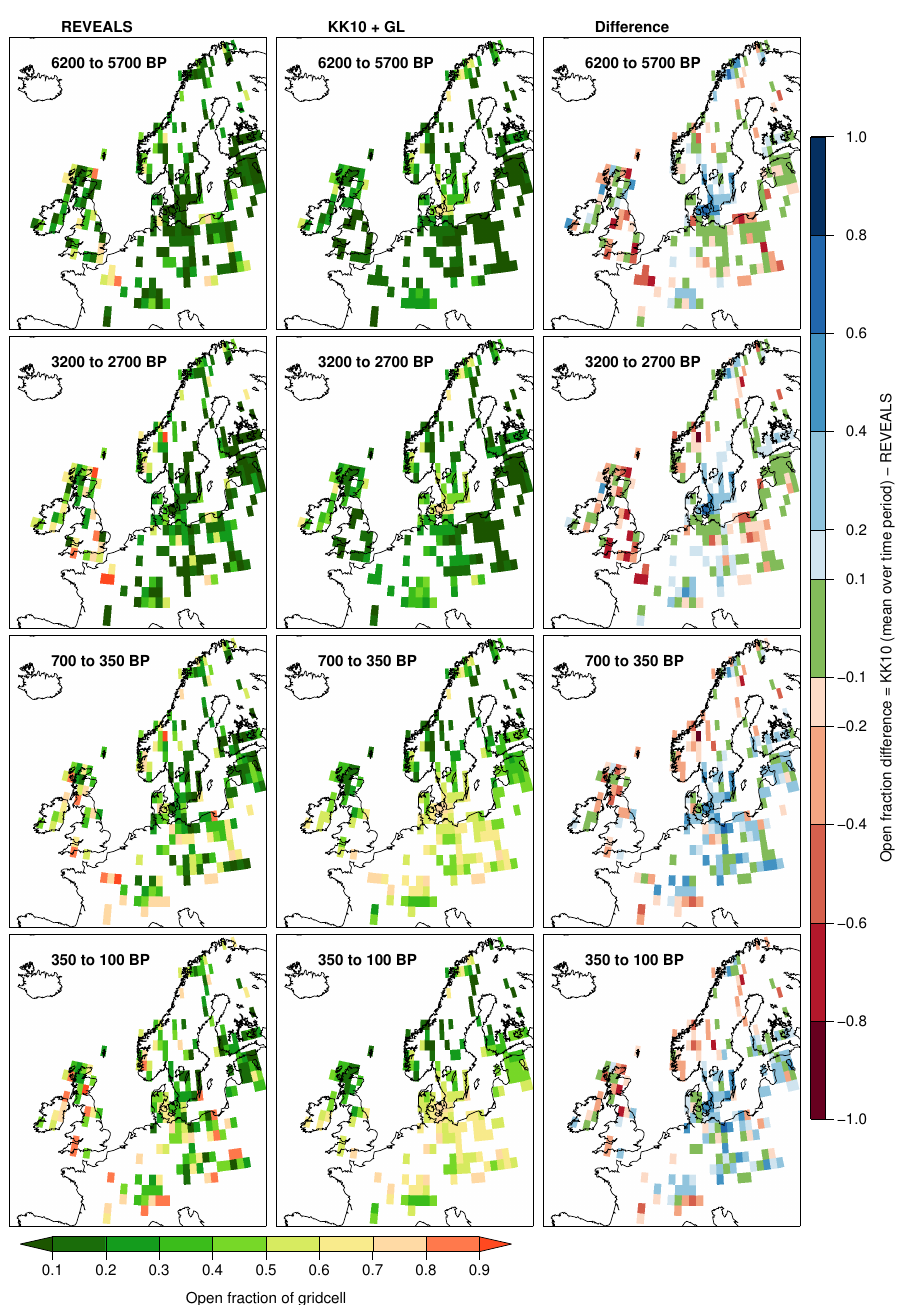
Figure 3. REVEALS open land (AL + GL) compared with land use estimates from KK10 and naturally treeless areas. The pollen-based reconstruction (left panels) is contrasted with the ALCC scenario (center panels). In the difference map (right panels), grid cells in blue show where there is more open land in the ALCC scenario, while grid cells in red show where there is more open land in the REVEALS reconstructions. Green grid cells indicate grid cells where REVEALS and the ALCC scenario agree within